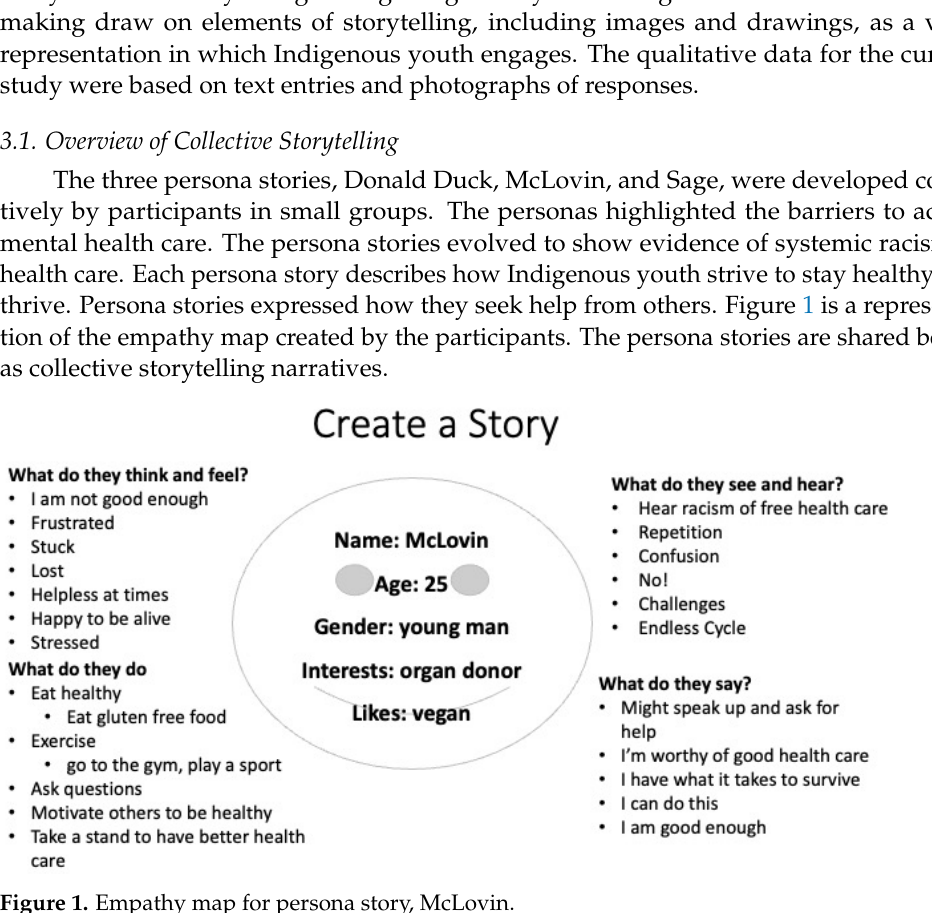
Figure 1. Empathy map for persona story, McLovin.